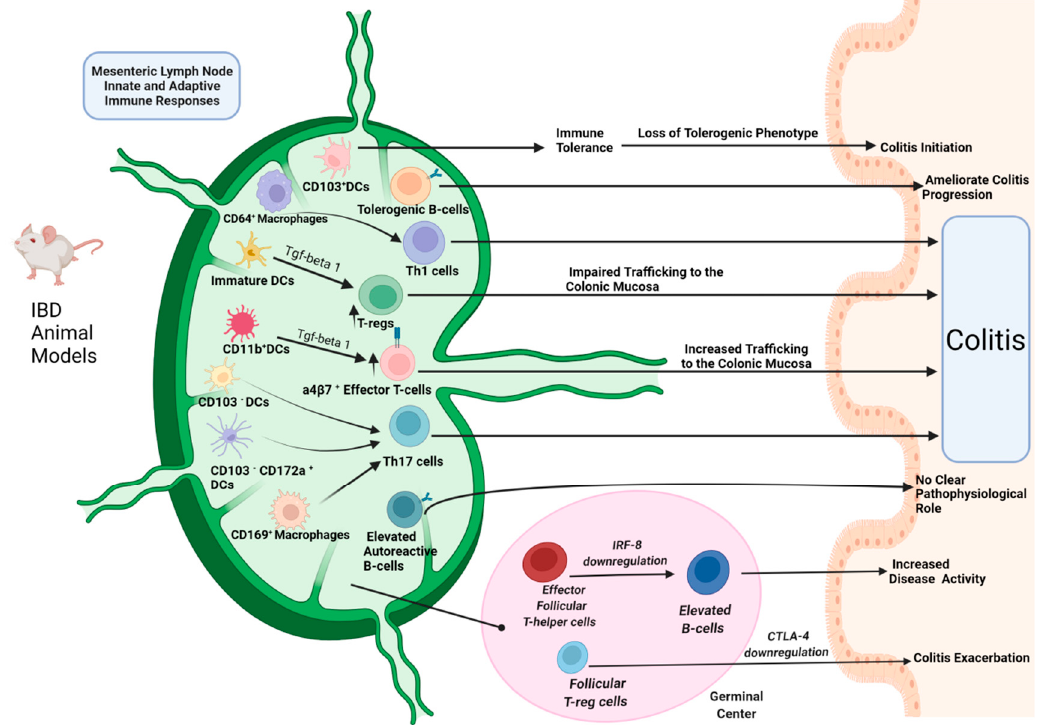
Figure 1. Adaptive and innate immune cell responses in mesenteric lymph nodes (MLNs) of IBD rodent models: Mature differentiated myeloid DC subsets orchestrate Th1 and Th17 inflammatory responses leading to disease onset, as well as, effector T-cell trafficking, whereas immature myeloid DCs induce immune tolerance by regulatory T-cell (T-reg) cell stimulation. Increased effector T-cell trafficking along with impaired T-reg trafficking to the colonic mucosa is associated with elevated inflammatory responses that can induce colitis. Tolerogenic MLN CD103 + DCs shift to a proin- flammatory phenotype leading to colitis initiation, while MLN CD103 − DCs induce primarily Th17 lymphocyte polarization. Elevated macrophage subsets promote Th1 and Th17 differentiation in MLNs. Both Th1 and Th17 cells are responsible for the disease onset. Activation of effector follicular T-helper cells along with the downregulation of follicular T-regs leads to disease exacerbation. El- evated autoreactive B-lymphocytes can lead to humoral autoimmunity in colitis mice but with no clear function in the disease pathophysiology, while tolerogenic B-cells can attenuate the disease progression. (Figure created with BioRender.com-accessed date: 20 December